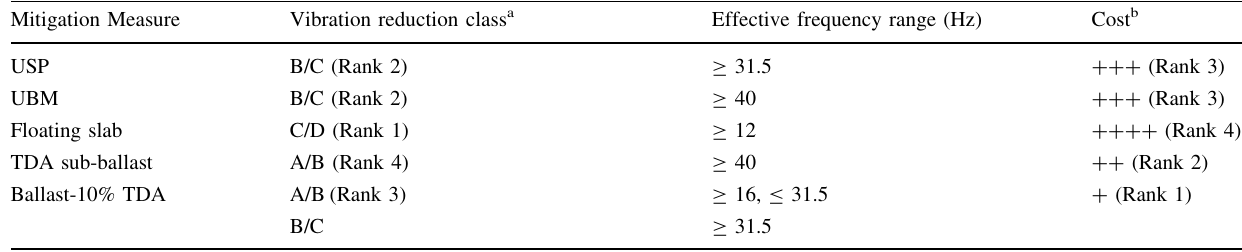
Table 4 Rank of Ballast-10% TDA in vibration mitigation measures Mitigation